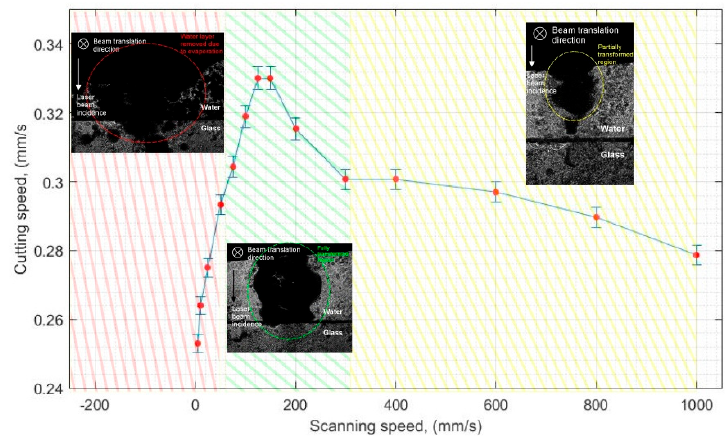
Figure 11. Sample cutting speed vs. beam scanning speed along the surface of the sample.